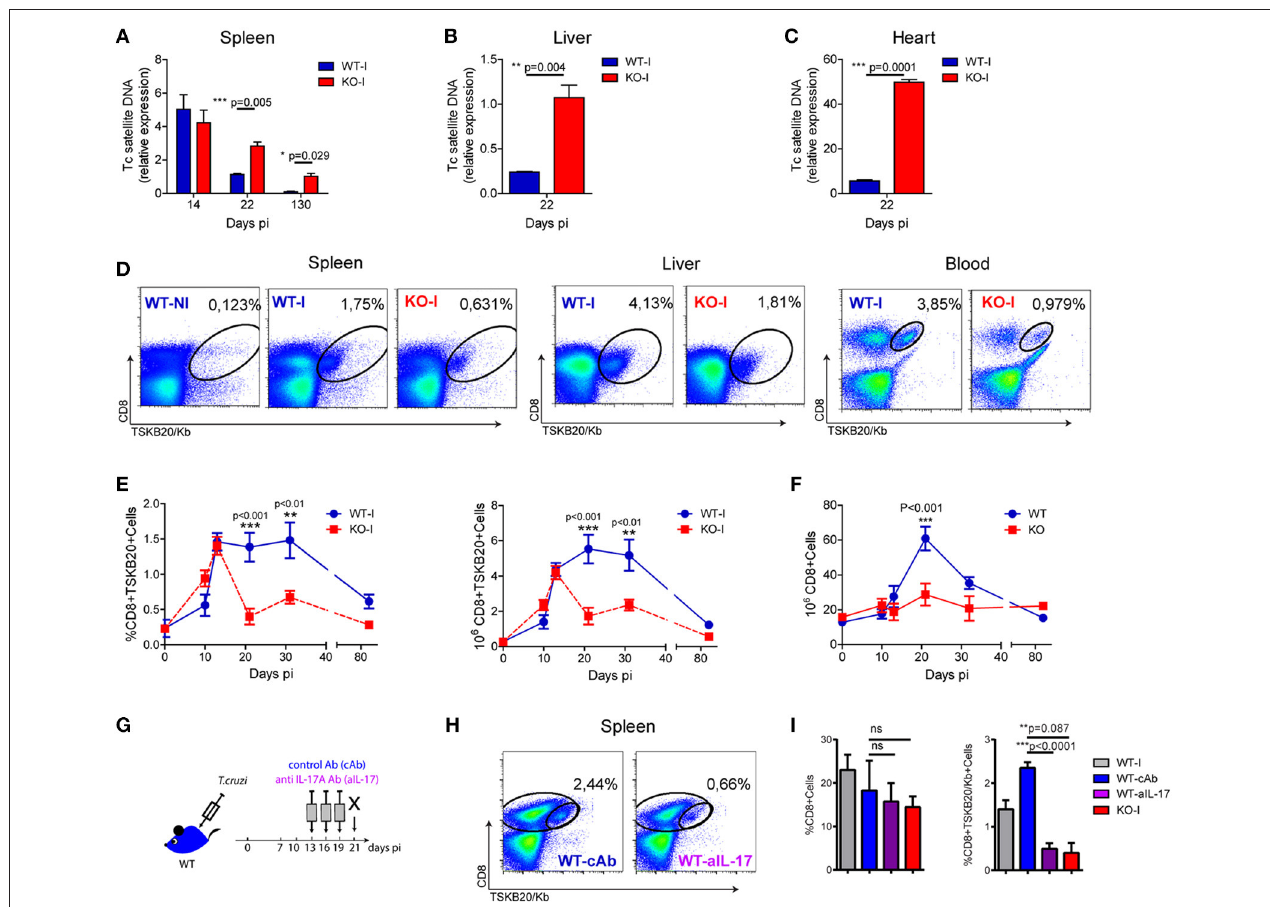
FIGURE 1 | Absence of IL-17RA signaling results in increased tissue parasitism and a reduced magnitude of parasite-specific CD8 + T cell responses. (A-C) Relative amount of T. cruzi satellite DNA in spleen (A) , liver (B) and heart (C) of infected WT and IL-17RA KO (KO) mice determined at the indicated dpi. Murine GAPDH was used for normalization. Data are presented as mean ± SD, N = 5 mice. P values calculated with two-tailed T test. (D) Representative plots of CD8 and TSKB20/Kb staining in spleen, liver and blood of WT and KO mice at 22 dpi (WT-I and KO-I, respectively). A representative plot of the staining of splenocytes from non-infected WT mice (WT-N) is shown for comparison. (E) Percentage and cell numbers of TSKB20/Kb + CD8 + T cells and (F) cell numbers of total CD8 + T cells determined in spleen of WT and IL-17RA KO mice at different dpi. Data shown as mean ± SD, N = 5 − 8 mice. P values calculated using two-way ANOVA followed by Bonferroni‘s post-test. (G) Experimental layout of IL-17 neutralization in infected WT mice injected with control isotype or anti-IL-17 Abs (WT-cAb and WT-aIL-17, respectively). (H) Representative plots of CD8 and TSKB20/Kb staining in spleen and liver infected control and treated WT mice. (I) Percentage of total and TSKB20/Kb + CD8 + T cells infected control and treated WT mice. Results from infection-matched WT (WT-I) and KO mice (KO-I) are shown for comparison. Data are representative of five (A–F) , and two (G–I) independent